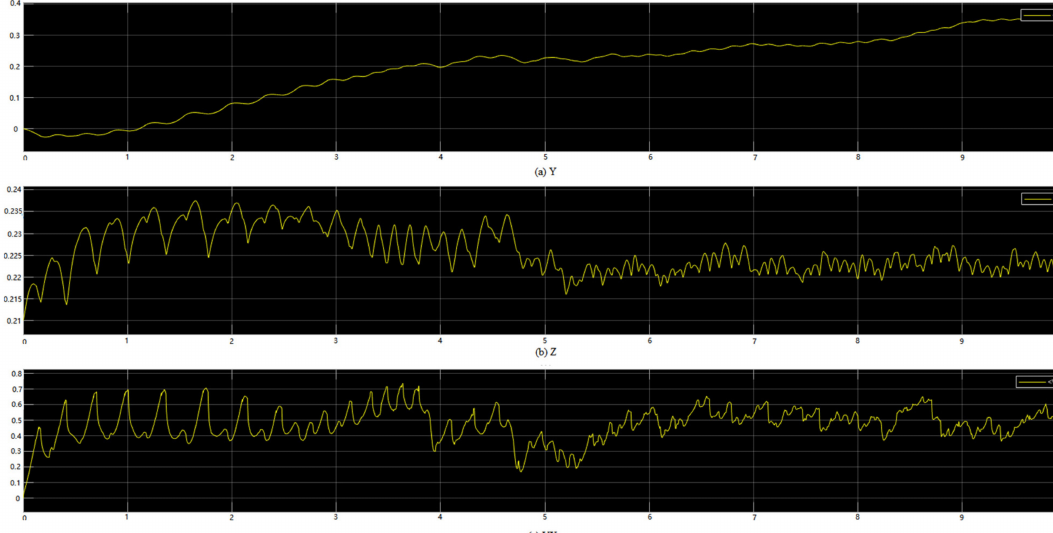
Figure 7. The state of the robot during one trajectory. The three figures from top to bottom are the lateral deviation, the change in gravity center and the forward speed of the